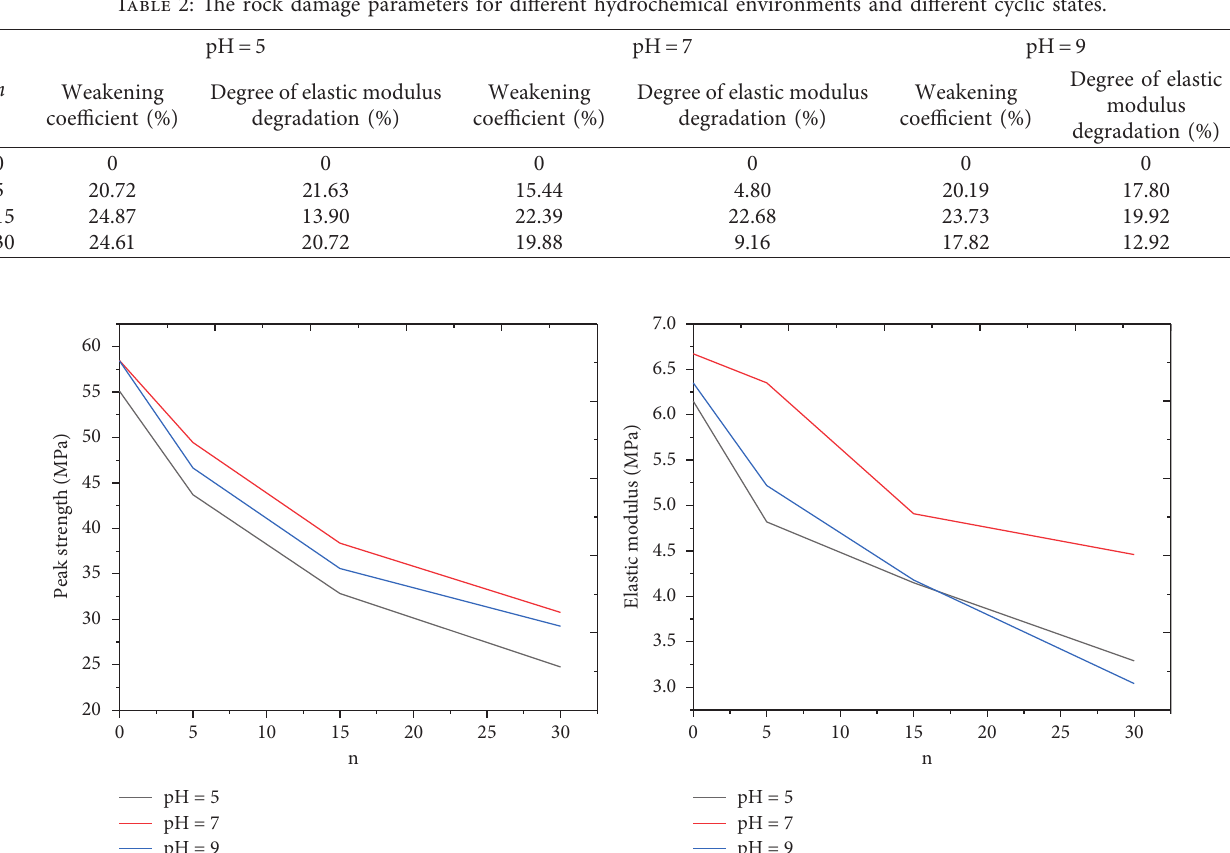
Table 2: The rock damage parameters for different hydrochemical environments and different cyclic states.